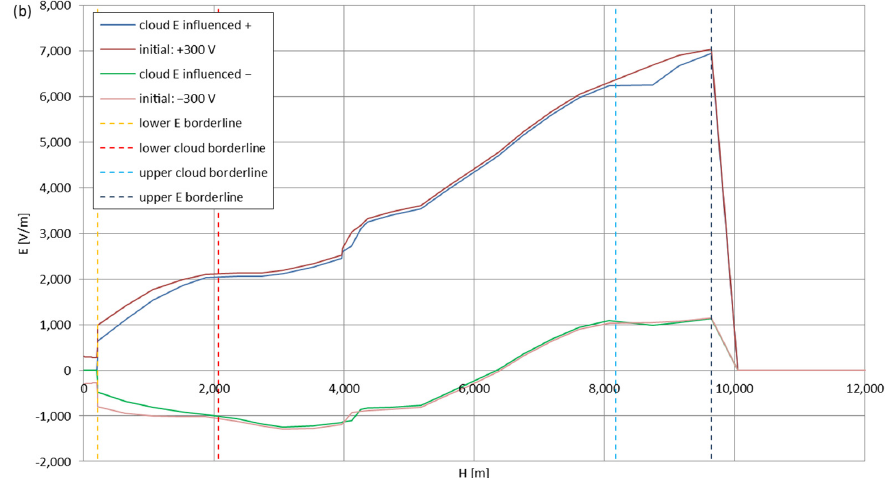
Figure 9. Maximum electric field strengths around the wire antenna passing through Nimbostratus cloud of mixed charge structure, Sankt Petersburg data: ( a ) ‘static’ case and ( b ) ‘dynamic’ case.